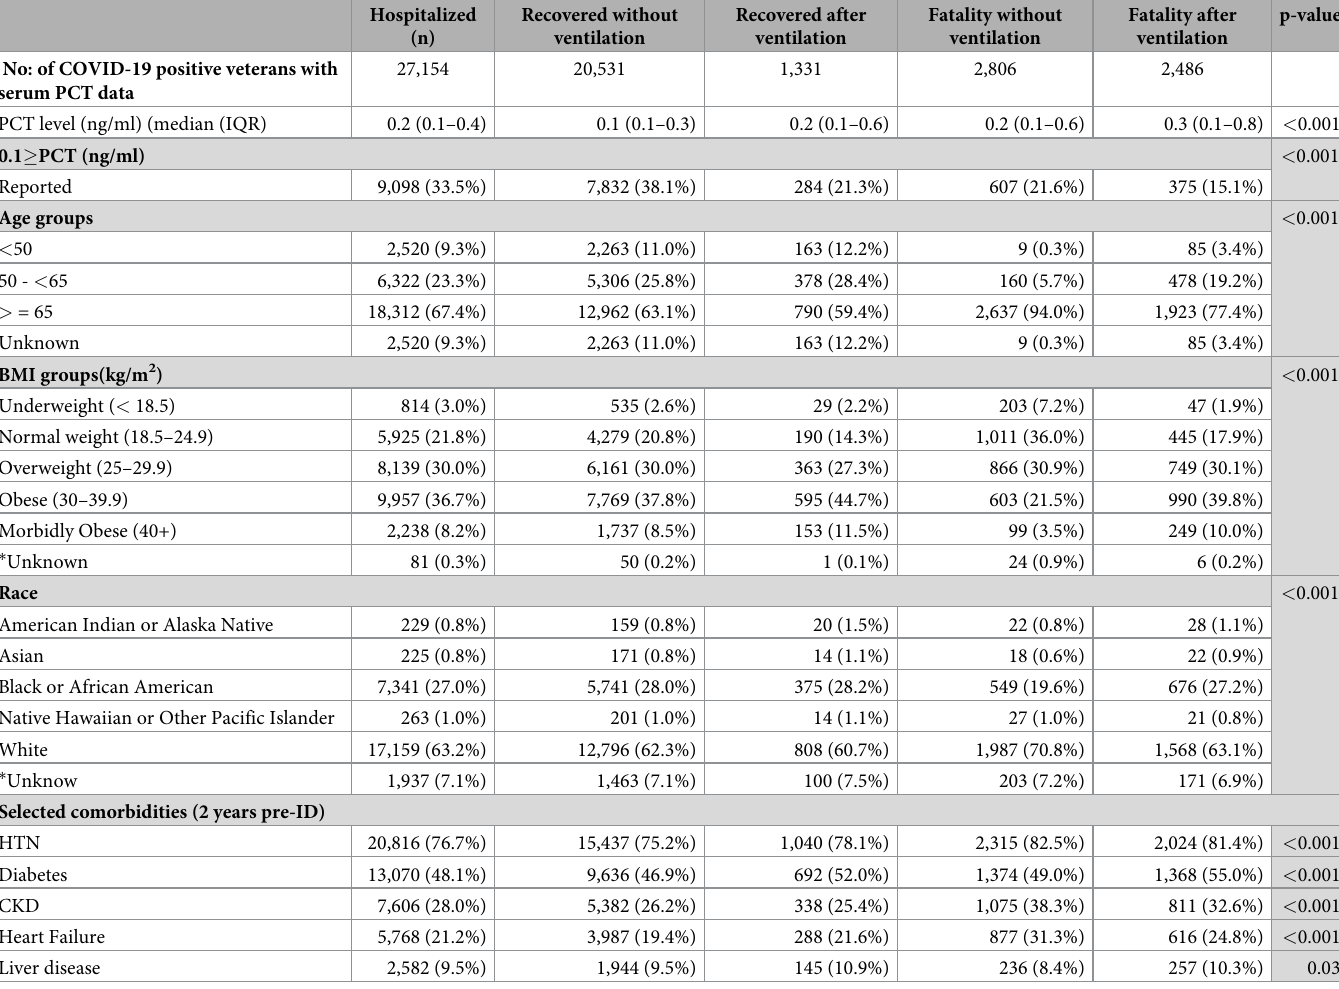
Table 1. Characteristics of 27,154 COVID-19-positive US veterans with at least one PCT measurement documented in their medical records between 01 March 2021 and 28 February 2022. * Unknown in the race, age, and BMI categories are those without any entry in the respective fields. Hospitalized (n)